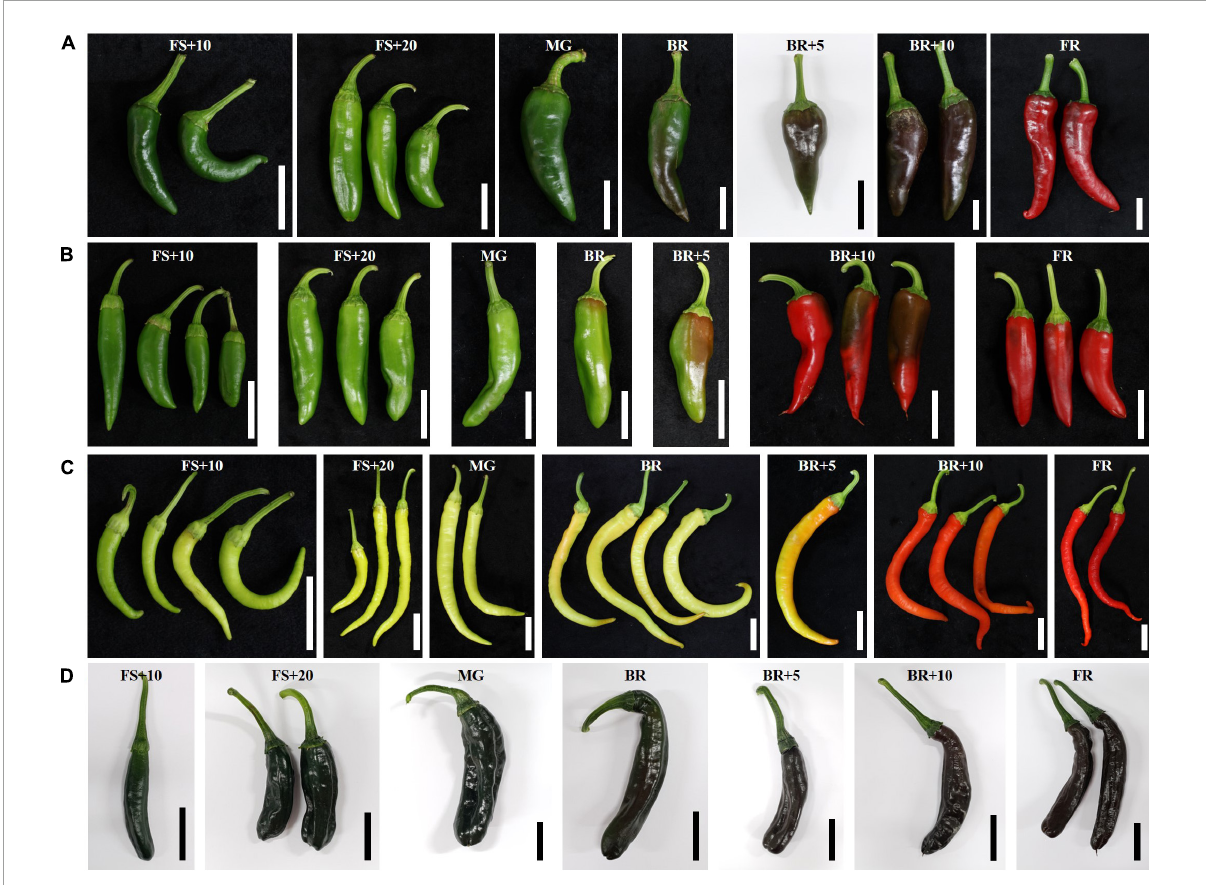
FIGURE1 Fruit color change during ripening of (A) “3501,” (B) “3509,” (C) “Long Sweet,” and (D) “AC2212.” FS, fruit set, MG, mature green, BK, breaker stage, FR, full red color fruit. White and black bars indicate 3